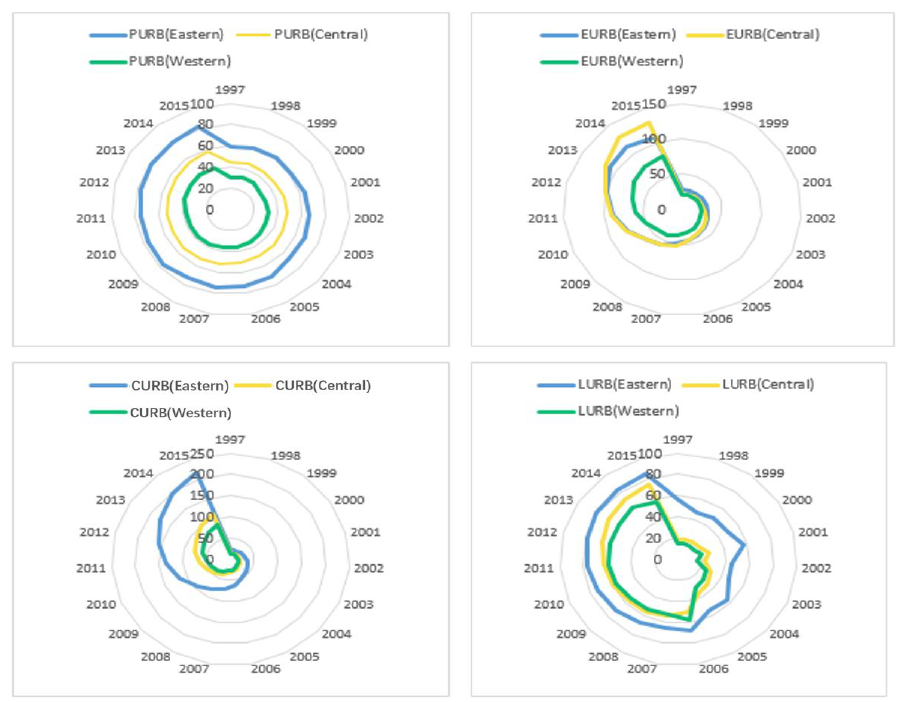
Figure 4. Four-dimensional urbanizations of eastern, central, and western China from 1997 to 2015 (Unit: %).